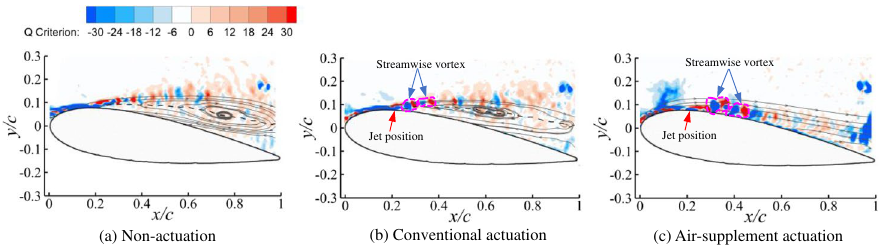
Fig. 11 Vortex contours and streamlines under different actuation states at α